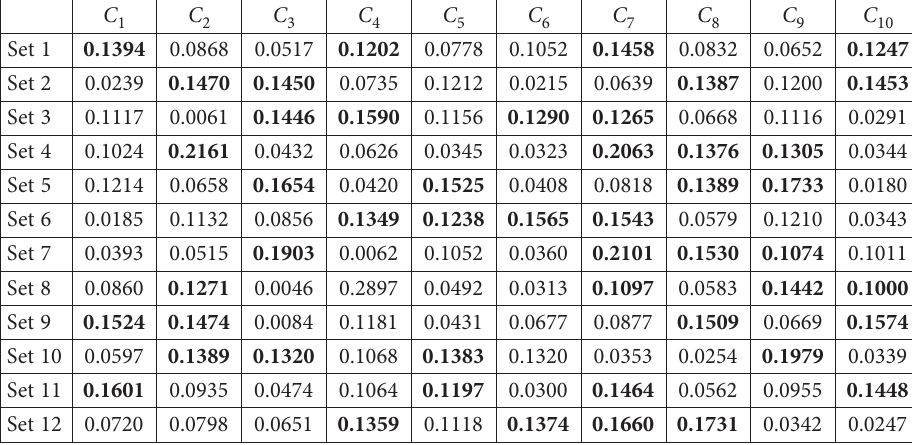
Table 12. Simulated weights of risk criteria in different sets